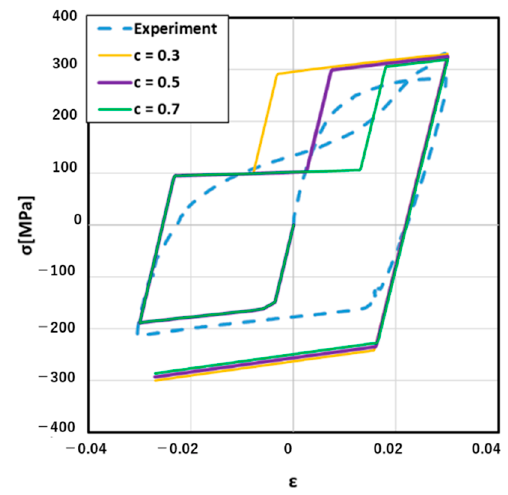
Figure 8. Results with different values for C.